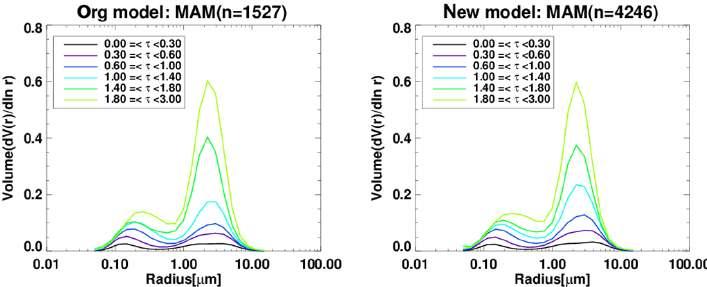
Figure 5. Volume size distribution for each AOD bin, as obtained from the original and new AERONET inversion data listed in Table 1. The effective radius and standard deviation of the fine- and coarse-mode particles are described in Table 2. The size distributions are averaged for each AOD interval, and the color of the curve indicates the mean AOD